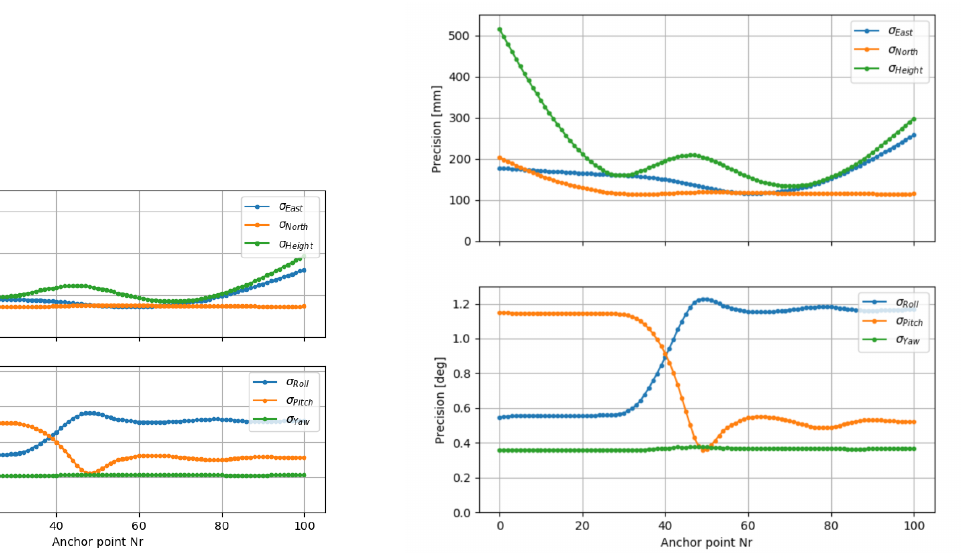
Figure 11. Results of platform back , scenario 3 (details see figure 9).